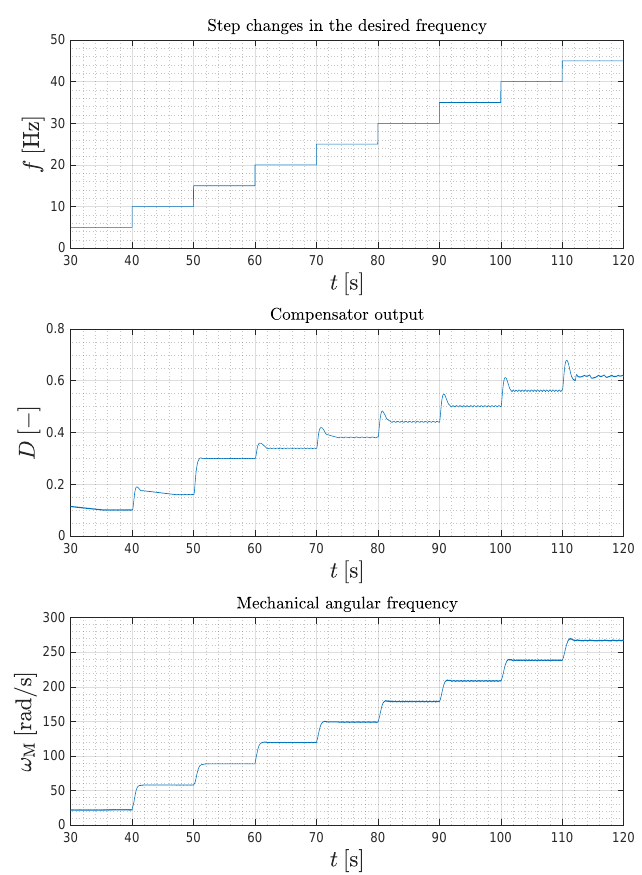
Figure 21. Simulated step-up response of the phase shift feedback control. The parameters for the two-phase induction motor used in simulation and experimental verification are shown in Table 5. Table 5. Parameters of the induction